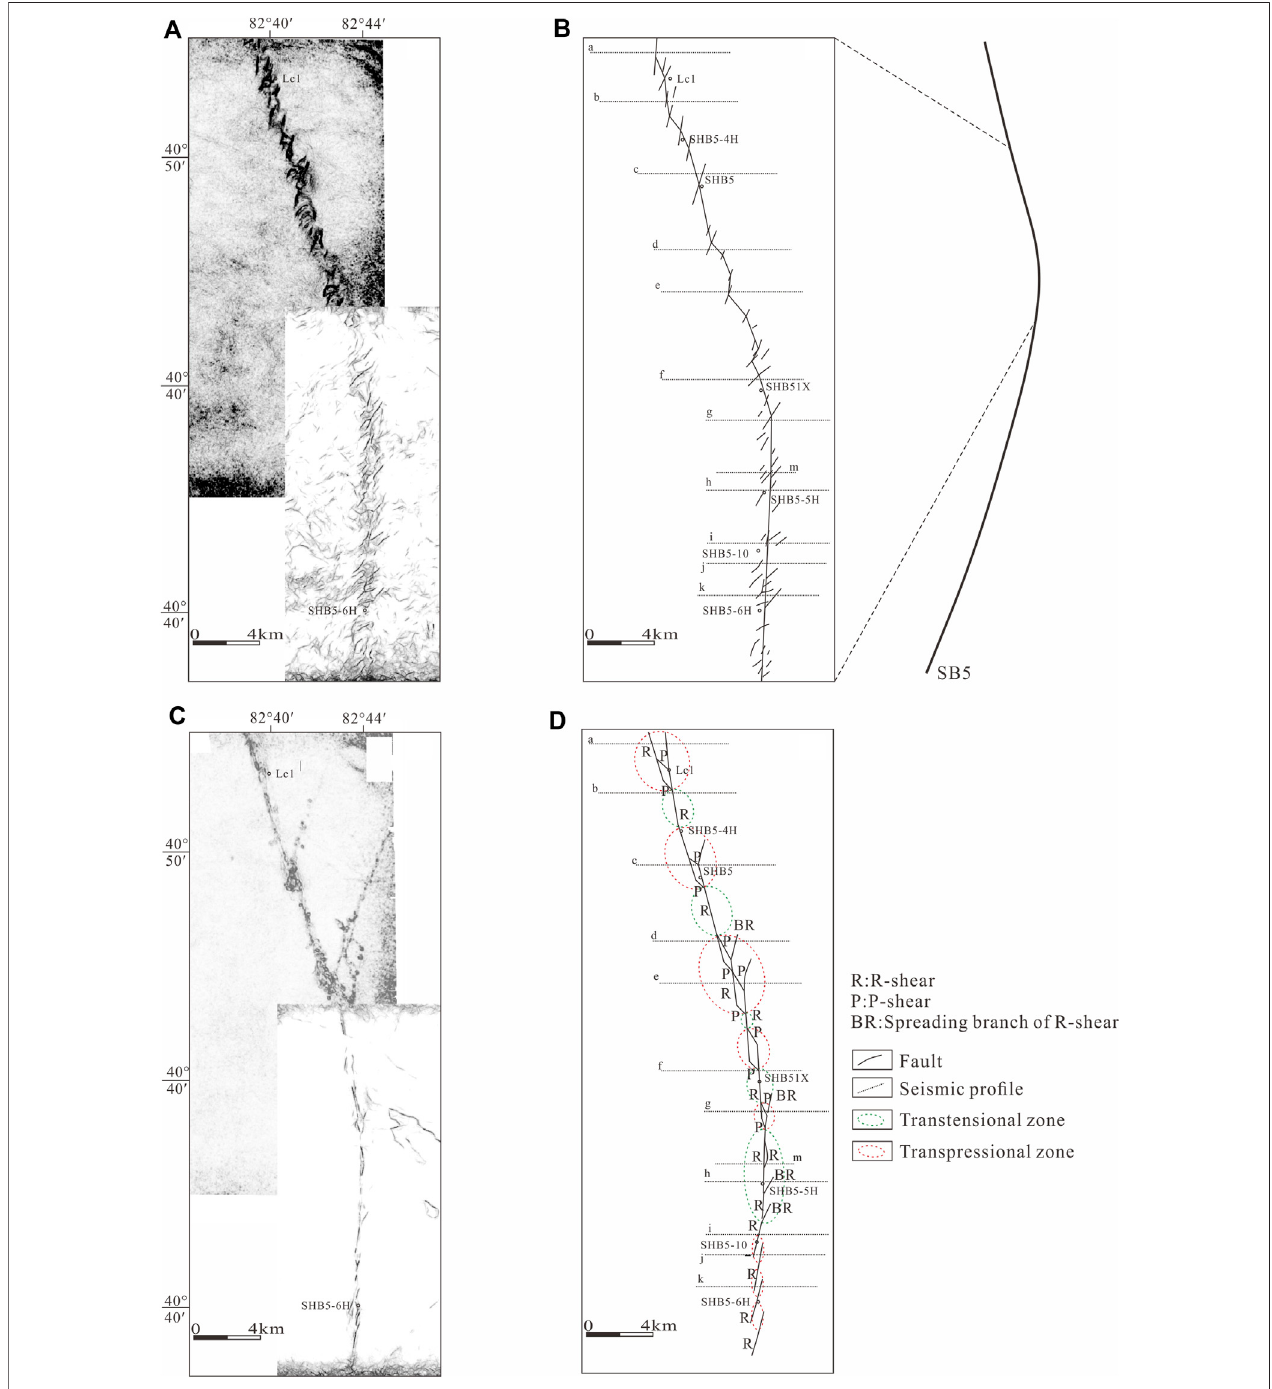
FIGURE5| 3DcoherencesliceoftheShunbei5strike-slipdeformationbelt(SB5). (A) T 70 re fl ectorindicatingthebottomoftheSilurian, (B) Faultinterpretationofa, (C) T 74 re fl ector indicating the bottom of the Upper Ordovician, (D) Fault interpretation of c.